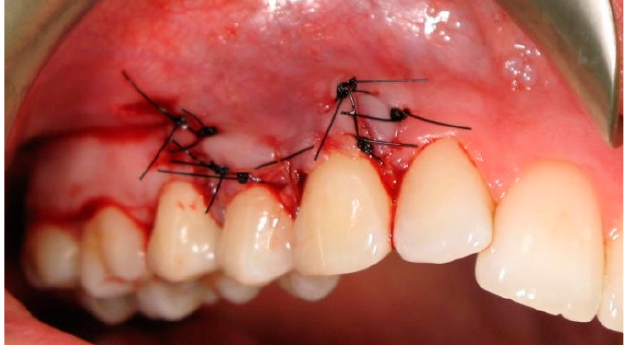
Figure 7. Clinical situation right after the surgical procedure.